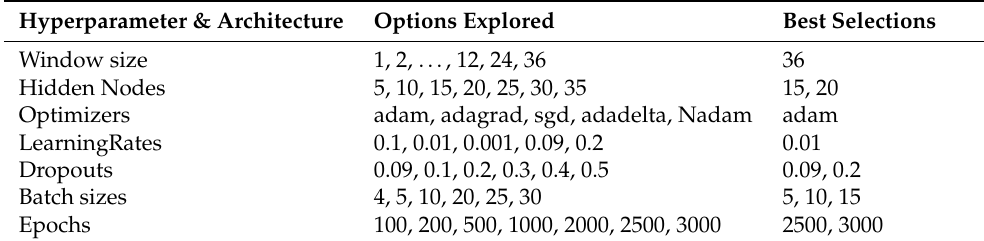
Table 3. Architectures and hyperparameters investigated for monthly precipitation and tempera- tures